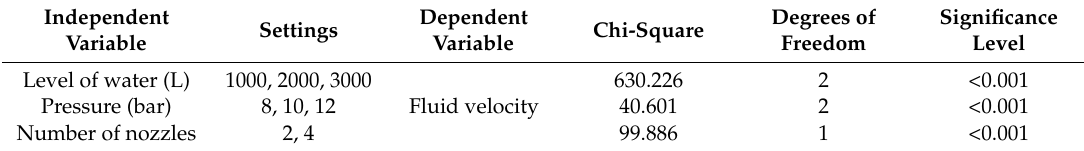
Table 4. Kruskal-Wallis test. Effect of the independent variables (level of water inside the tank; pressure of the nozzle circuit; number of nozzles working simultaneously) on the fluid